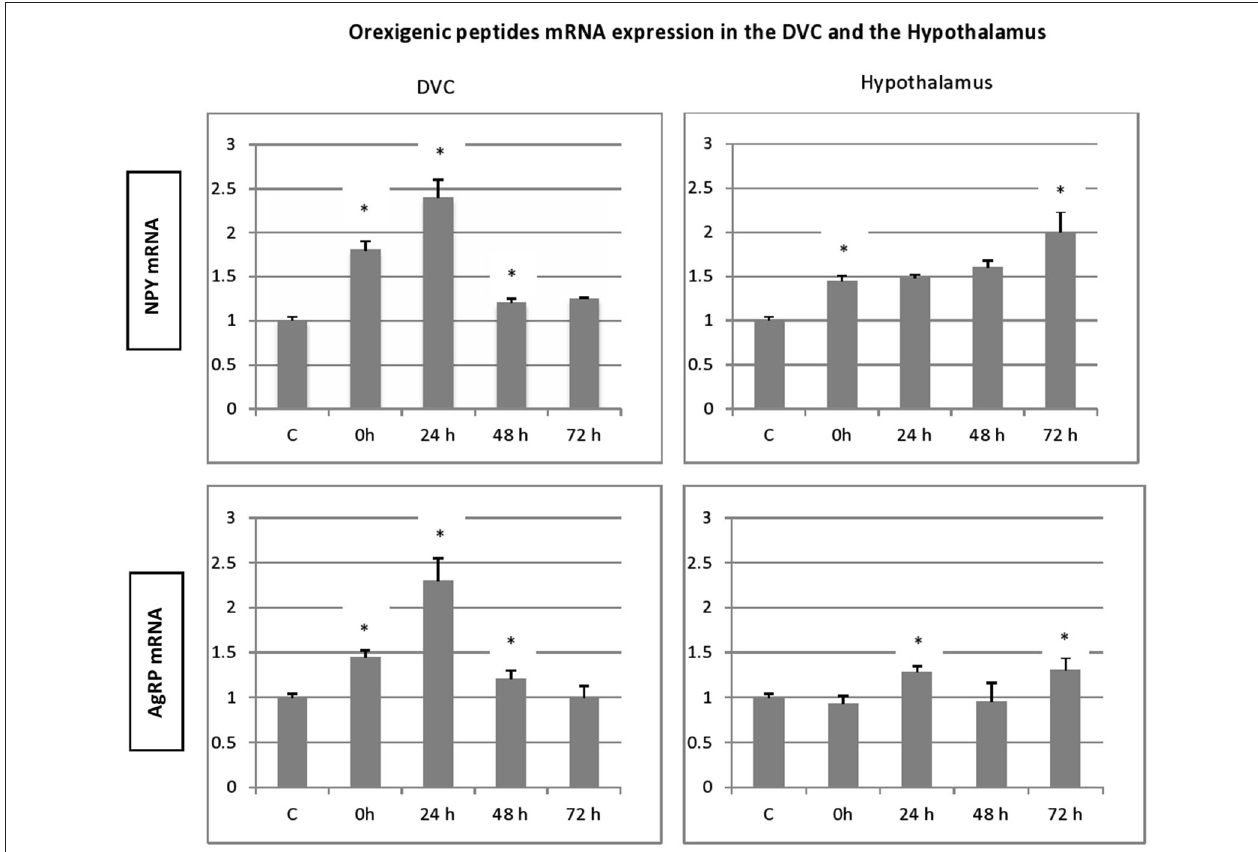
FIGURE 3 | Time-course and dynamic changes of the effects of 1 h stress immobilization session on profiles in hypothalamic NPY mRNA, AgRp mRNA, POMC mRNA and CART mRNA (data from 6–11 rats/time point) . ∗ significantly different from control rats. p < 0.05.